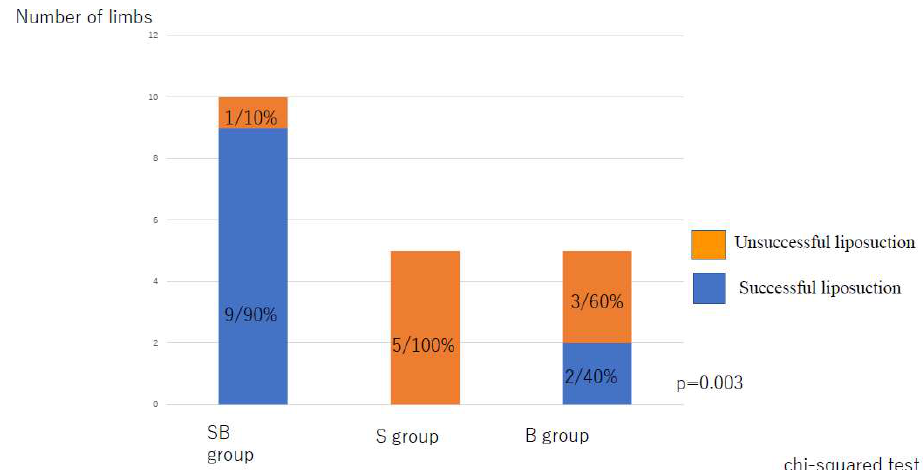
Figure 7. Liposuction success rate according to type of postoperative compression strategy. B, bandage only; SB, compression stocking and bandage; S, stocking only.